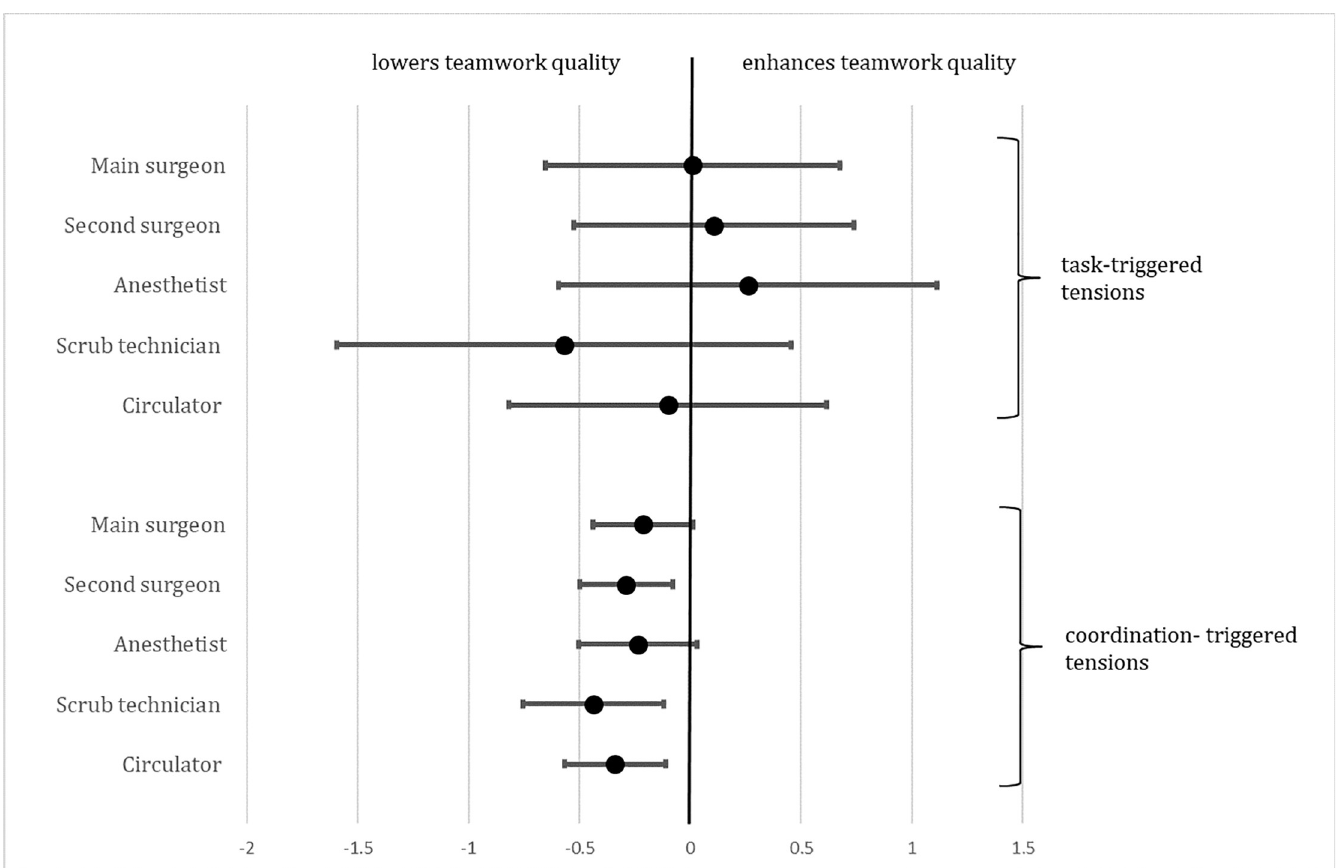
Fig 3. Illustration of effect of task-triggered and coordination-triggered tensions on teamwork quality for surgeons, anesthetists and scrub nurses.